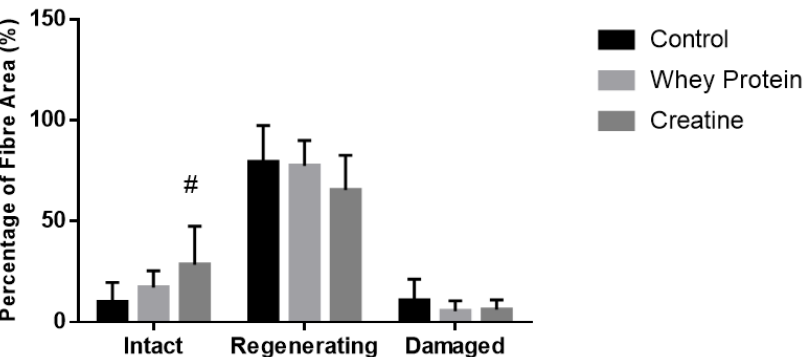
Figure 4. Muscle fiber recovery (expressed as a % of muscle CSA) of injured EDL muscles from rats treated with standard rat chow- (CON-), whey protein- (WP-), or creatine- (CR-) supplemented rat chow at day 7 post-injury. Values are mean ± SD expressed as either % of damaged fibers, regenerating fibers, and undamaged (intact) fibers. # ( p < 0.01) significantly different from the injured CON values.